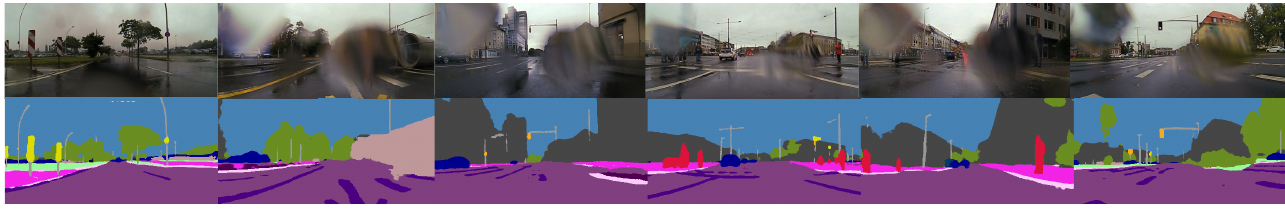
Figure 13. Semantic segmentation results in adverse weather conditions with heavy rain.